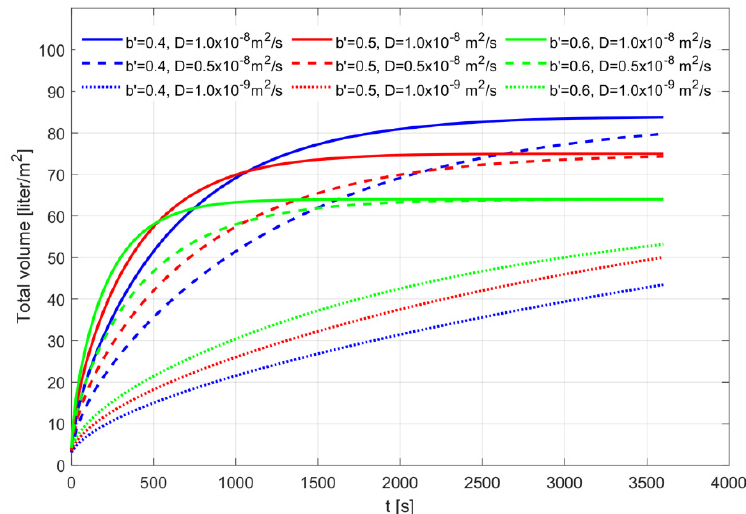
Figure 7. Total water volume per square meter captured by the Down-flow SPB storage (Down3) for diffusion constants D and parameters b’ as a function of time. Graph lines: solid, D = 1.0 × 10 − 8 m 2 / s; dashed, D = 0.5 × 10 − 8 m 2 / s; and, dotted, D = 1.0 × 10 − 9 m 2 / s. Graph colors: blue, b (cid:48) = 0.4, red, b (cid:48) = 0.5, and green, b (cid:48) = 0.6 .